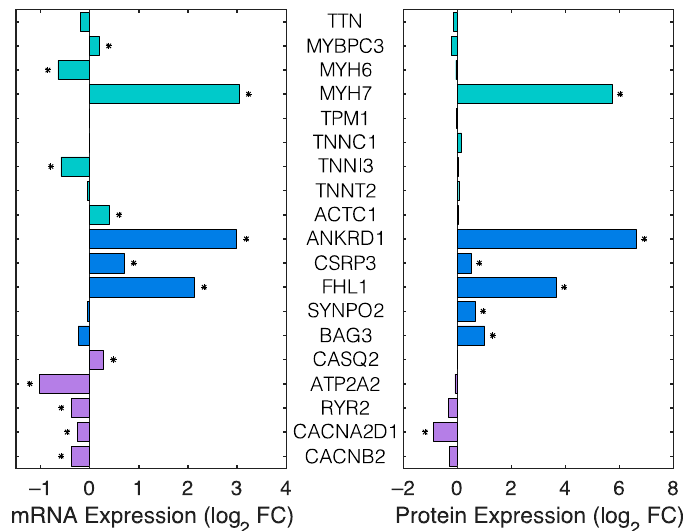
Figure 2. The effects of FLNC deletion in adult mouse hearts on mRNA and protein expression. The log 2 fold-changes (FC) of mRNA expression ( left ) and protein expression ( right ) in icKO hearts relative to control hearts are shown for myofilament-associated proteins (teal), Z-disk/costamere-associated proteins (blue), and Ca 2+ signaling-associated proteins (purple). Fold-changes in mRNA and protein expression were determined using RNA-seq and mass spectrometry (respectively) for N = 3 mice from each group, and * indicates p < 0.05. TTN: titin; MYBP3: myosin-binding protein C; MYH6: α -myosin heavy chain; MYH7: β -myosin heavy chain; TPM1: α -tropomyosin; TNNC1: cardiac troponin C; TNNI3, cardiac troponin I; TNNT2, cardiac troponin T; ACTC1, cardiac sarcomeric actin; ANKRD1: cardiac ankyrin repeat protein (CARP); CSRP3: muscle LIM protein; FHL1, four-and-a-half LIM domain protein 1; SYNPO2: synaptopodin-2; BAG3: co-chaperone Bcl2-associated athanogene 3; CASQ2: calsequestrin-2; ATP2A2, sarcoplasmic reticulum Ca 2+ -ATPase; RYR1, ryanodine receptor; CACNA2D1, voltage-dependent calcium channel subunit alpha-2/delta-1; CACNB2, calcium voltage-gated channel auxiliary subunit beta